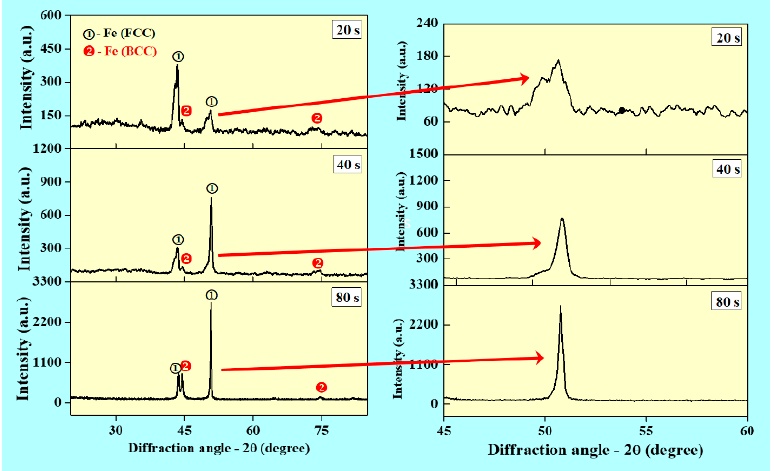
Figure 6. X-ray diffraction (XRD) patterns showing the influence of interlayer delay w.r.t. the phase formation.